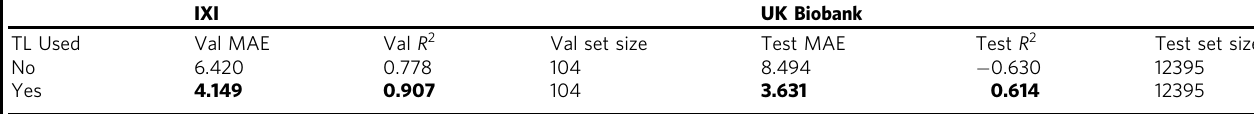
Table 2 UK Biobank and IXI prediction performance with and without transfer